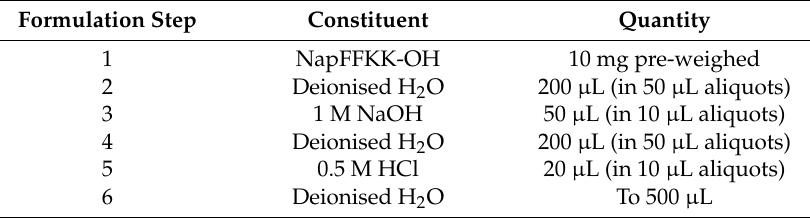
Table 1. Stepwise formulation of a self-assembling pH-triggered 2% w / v NapFFKK-OH (500 µ